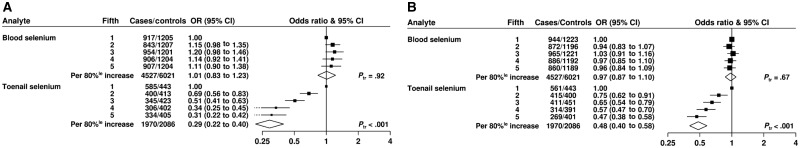
Odds ratios (95% confidence intervals [CIs]) of prostate cancer associated with fifths of blood and nail selenium concentration, adjusted for age at blood collection, body mass index, height, marital status, education, and smoking. The Ptrend was calculated by replacing the fifths of selenium with a continuous variable that was scored as 0, 0.25, 0.5, 0.75, and 1 in the conditional logistic regression model. Median concentrations in each fifth (using overall cutpoints) are: 874, 1184, 1467, 1677, and 1939 nmol/L for blood selenium and 0.46, 0.54, 0.63, 0.77, and 0.96 ppm for nail selenium. All statistical tests were two-sided. Results in the figures are presented as squares and lines, representing the odds ratios and corresponding 95% confidence intervals, respectively. The position of the square indicates the value of the odds ratio while the size of the square is inversely proportional to the variance of the logarithm of the odds ratio and indicates the amount of statistical information available for that particular estimate. The open diamonds (the lateral points of which are the 95% CIs) represent the overall odds ratio for an 80th percentile increase in selenium concentration. 80%le = 80 percentile; CI = confidence interval; OR = odds ratio; Ptr = Ptrend.